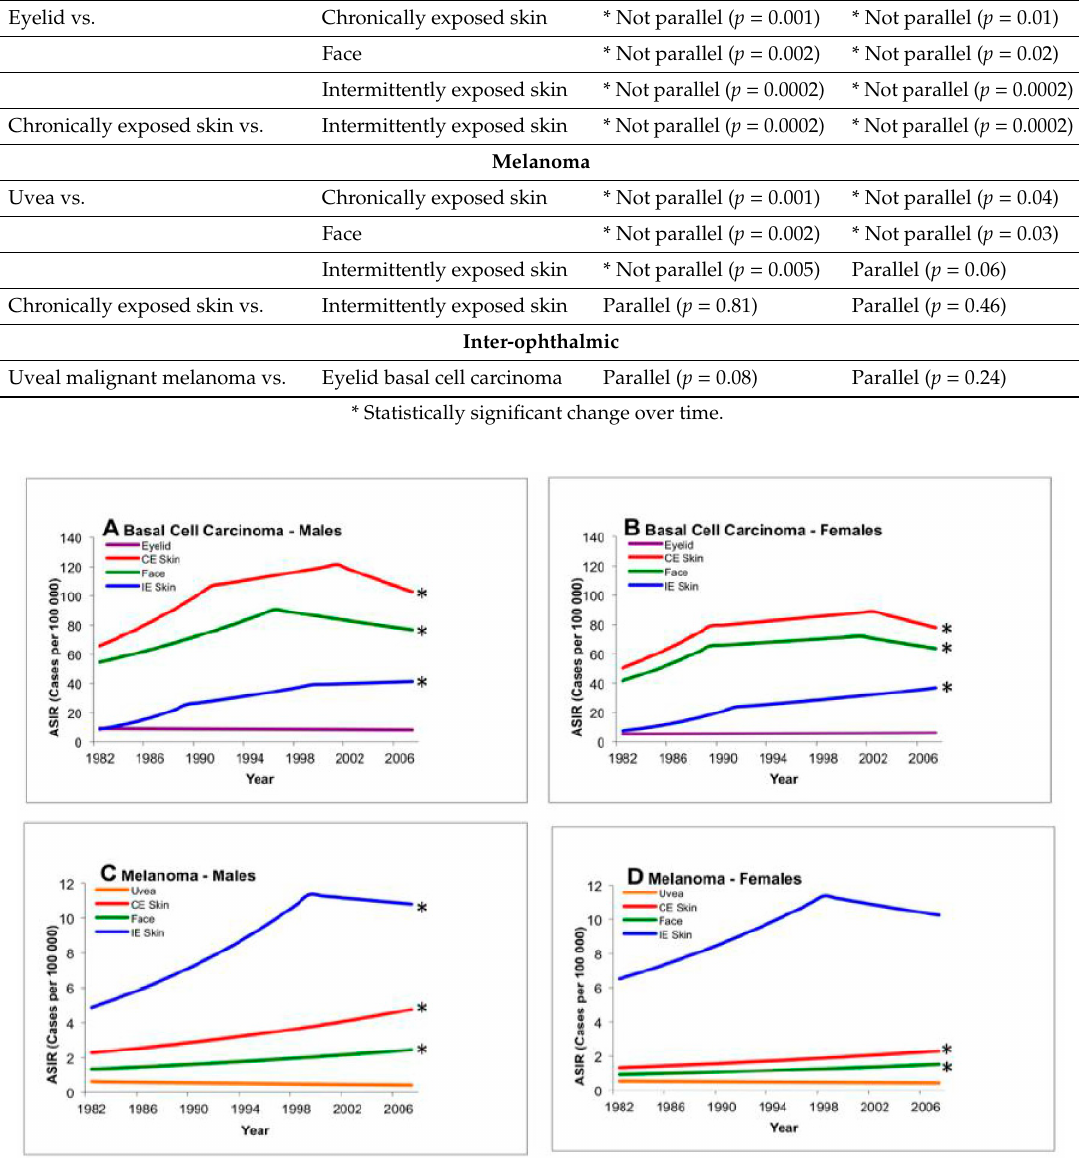
Figure 1. Test of parallelism comparing incidence trends of ocular and cutaneous tumors using registry data, 1982–2007. There is a statistically significant rising incidence in basal carcinoma and cutaneous melanoma of the face, intermittently exposed skin, and chronically exposed skin when compared to uveal melanoma or basal carcinoma of the eyelid. * Denotes non-parallel trend from baseline (eyelid or uvea, p < 0.05). ASIR: age-standardized incidence rate; CE: chronically exposed; IE: intermittently